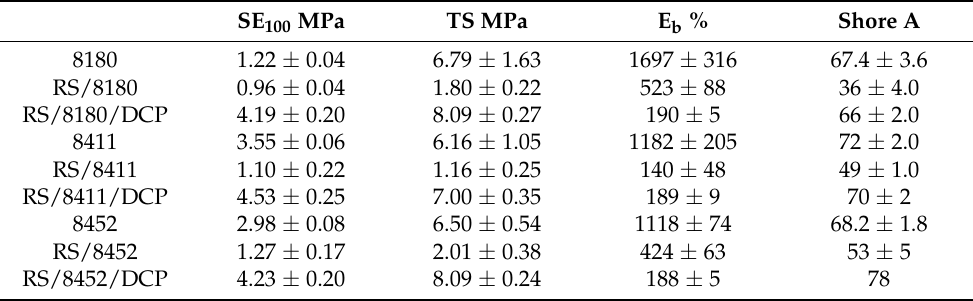
Table 2. The static mechanical properties of TPEs and their blends. Stress at 100% of elongation SE 100 , tensile strength TS, elongation at break E b , hardness (Shore